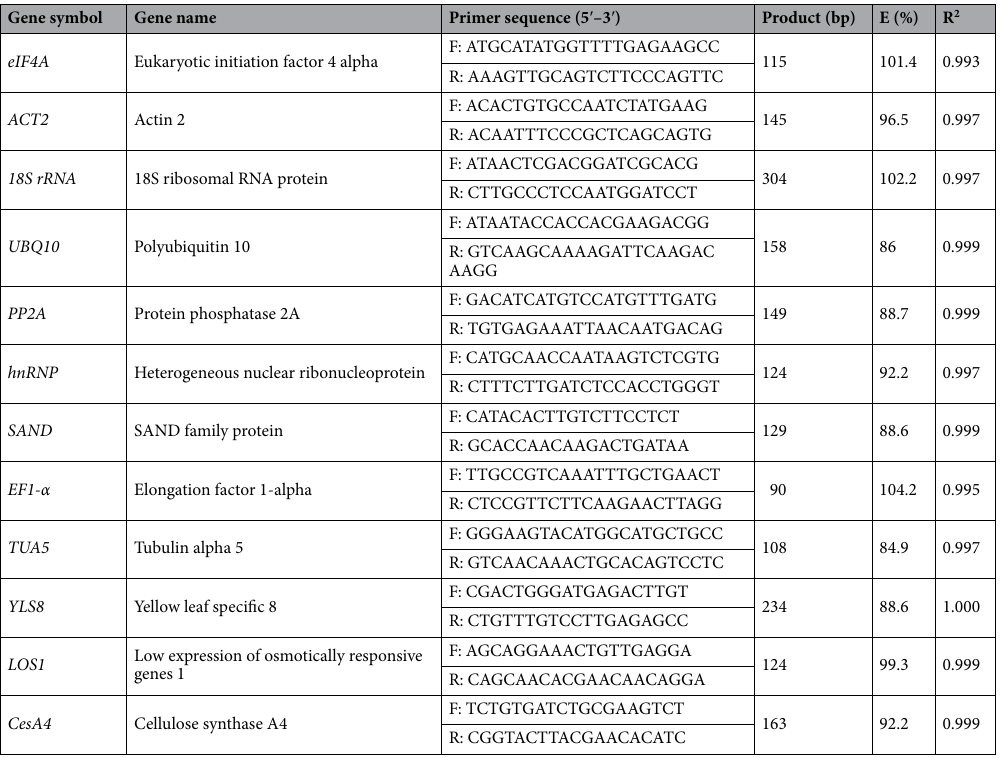
Table 1. Details of primers used in this